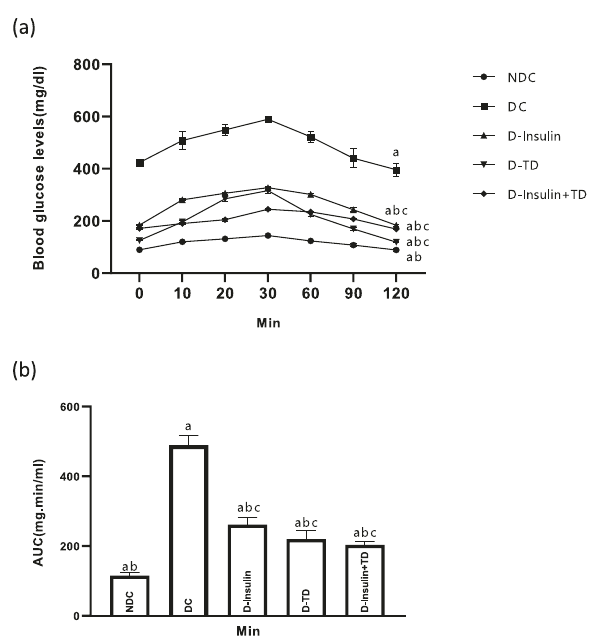
Fig. 2 Effect of TD on changes in blood glucose levels in the glucagon tolerance test (GTT) of male rats. Comparison of last month ’ s glucagon tolerance test (GTT) ( a ) and the area under the glycemic curve (AUC) ( b ) in the non-diabetic control (NDC), diabetic control (DC), D-insulin, D-TD, and D-insulin + TD groups. DC group received 60 mg/kg STZ. D-insulin group diabetic animals were treated with 2.5 U/kg insulin twice per day (1/3 morning and 2/3 in the evening), the D-TD group diabetic animals were treated with daily IP injection of 40 mg/kg thiamine disul fi de, D-insulin + TD group diabetic animals treated with TD and insulin (2.5 U/kg insulin + 40 mg/kg TD once per day). Data are expressed as mean ± S.E.M ( N = 7). a Signi fi cant difference in AUC and GTT between the DC group and other groups (DC vs NDC ( p < 0.0001), DC vs other treatments ( p < 0.001). b Signi fi cant difference in AUC and GTT between the NDC group and other groups ( p < 0.001). c Signi fi cant difference in AUC and GTT between the D-insulin group and the other two treatments (D-TD and D-insulin + TD) groups ( p < D-insulin: 31960 ± 483.58 mg.min/ml D-TD: 25210 ± 318.44 mg. min/ml D-insulin + TD: 25388.75 ± 148.58 mg.min/ml). Effect of TD on (ITT) At the end of the study, ITT was performed for all animals. The level of AUC in the DC group was higher than the NDC group and all treatment groups ( p < 0.0001; Fig. 3a, b). But the AUC did not reach the NDC level in all treatment groups (Fig. 3b, c). There was not a signi fi cant difference between the two groups of D-insulin and D-insulin + TD (Fig. 3c). (NDC: 10172.5 ± 442.82 mg.min/ml DC: 44086.25 ± 3027.47 mg.min/ml D-insulin: 16908.75 ± 356.85 mg. min/ml D-TD: 13927.5 ± 226.66 mg.min/ml D-insulin + TD: 16161.25 ± 362.52 mg.min/ml). Effect of TD in the IIR After 14 weeks of treatment, a hyperglycemic-euinsulinemic clamp test was performed to assess whole-body insulin sensitivity in all animals. In this type of test, the blood glucose level was clamped at 100 ± 5 mg/dl. TD therapy signi fi cantly increased ( p < 0.0001) the rate of insulin injection (IIR) required to maintain euglycemia during the injection of constant glucose rate in comparison with the DC group (Fig. 4). IIR was lower in D-TD group rats than in animals in the D-insulin and D-insulin + TD groups. ( p < 0.001, Fig. 4). In all treatment groups, the rate of IIR was higher than in the NDC group ( p < 0.0001; Fig. 4). (NDC: 0.2678 ± 0.06 μ /min/kgbw DC: 6.3027 ± 0.23 μ /min/kgbw D-insulin: